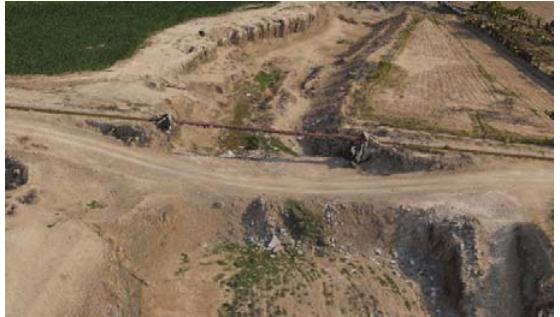
Figure 6. Dense point